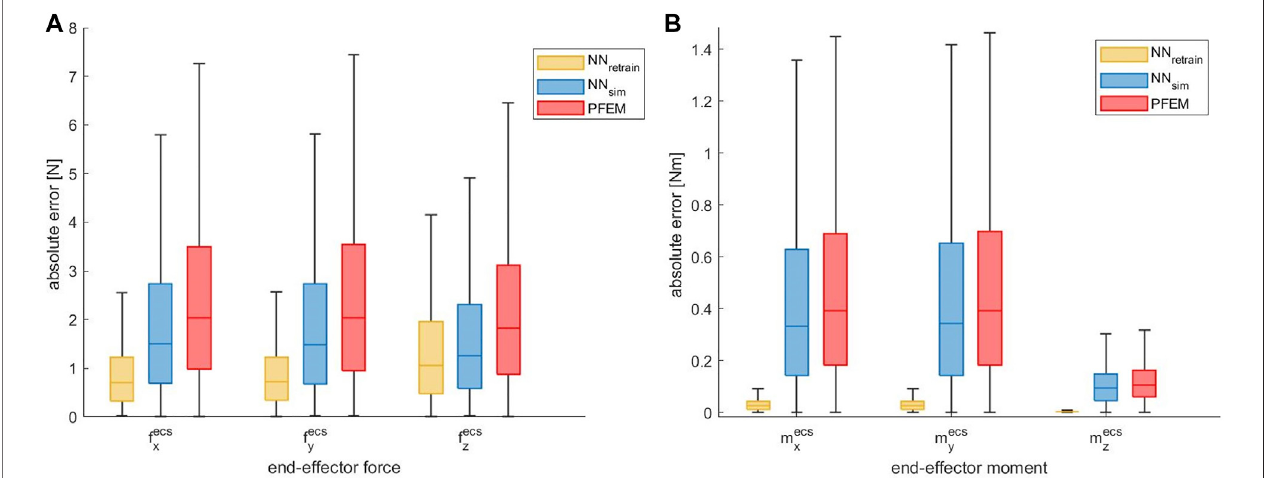
FIGURE5|(A) Absoluteend-effectorforceerroroftheANNapproachcomparedtothePFEMgivenforeachaxisinlinearscaleevaluatedonthe dataset gen , dir .The median error couldbelargelyreducedbytheANN,whichwasretrained withrealrobot data. (B) Absoluteend-effector moment erroroftheANN approachcompared to the PFEM given for each axis in linear scale evaluated on the dataset gen , dir .